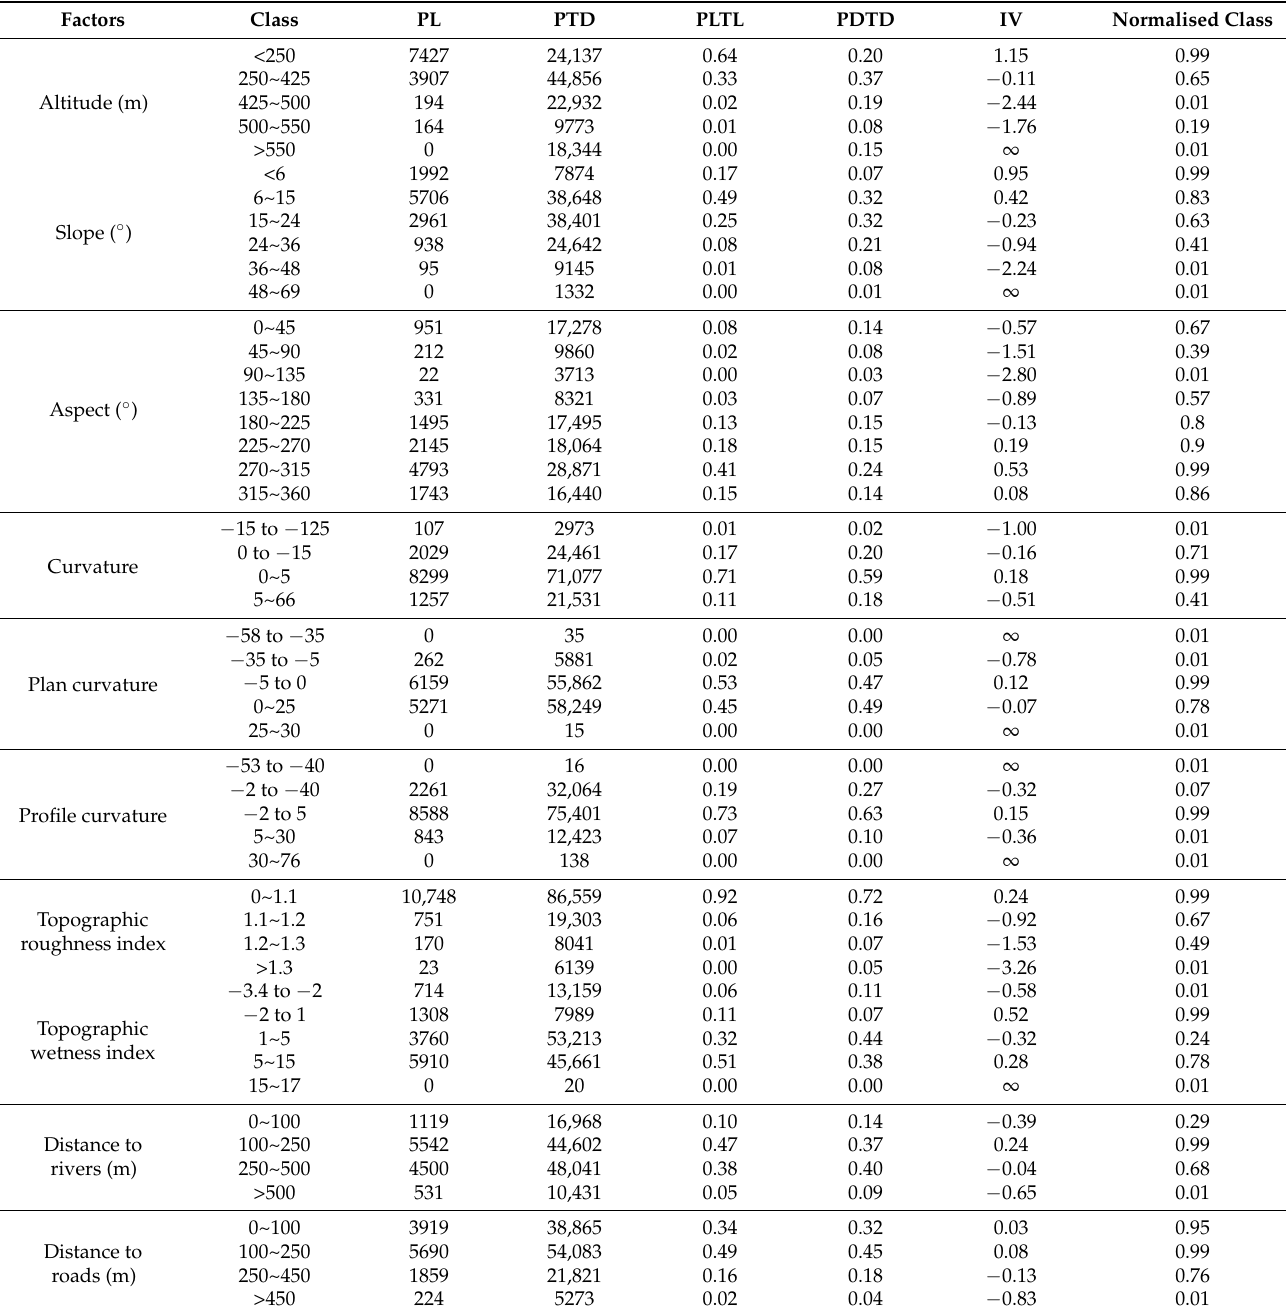
Table 1. Spatial relationships between landslide causal factors and landslides using IV